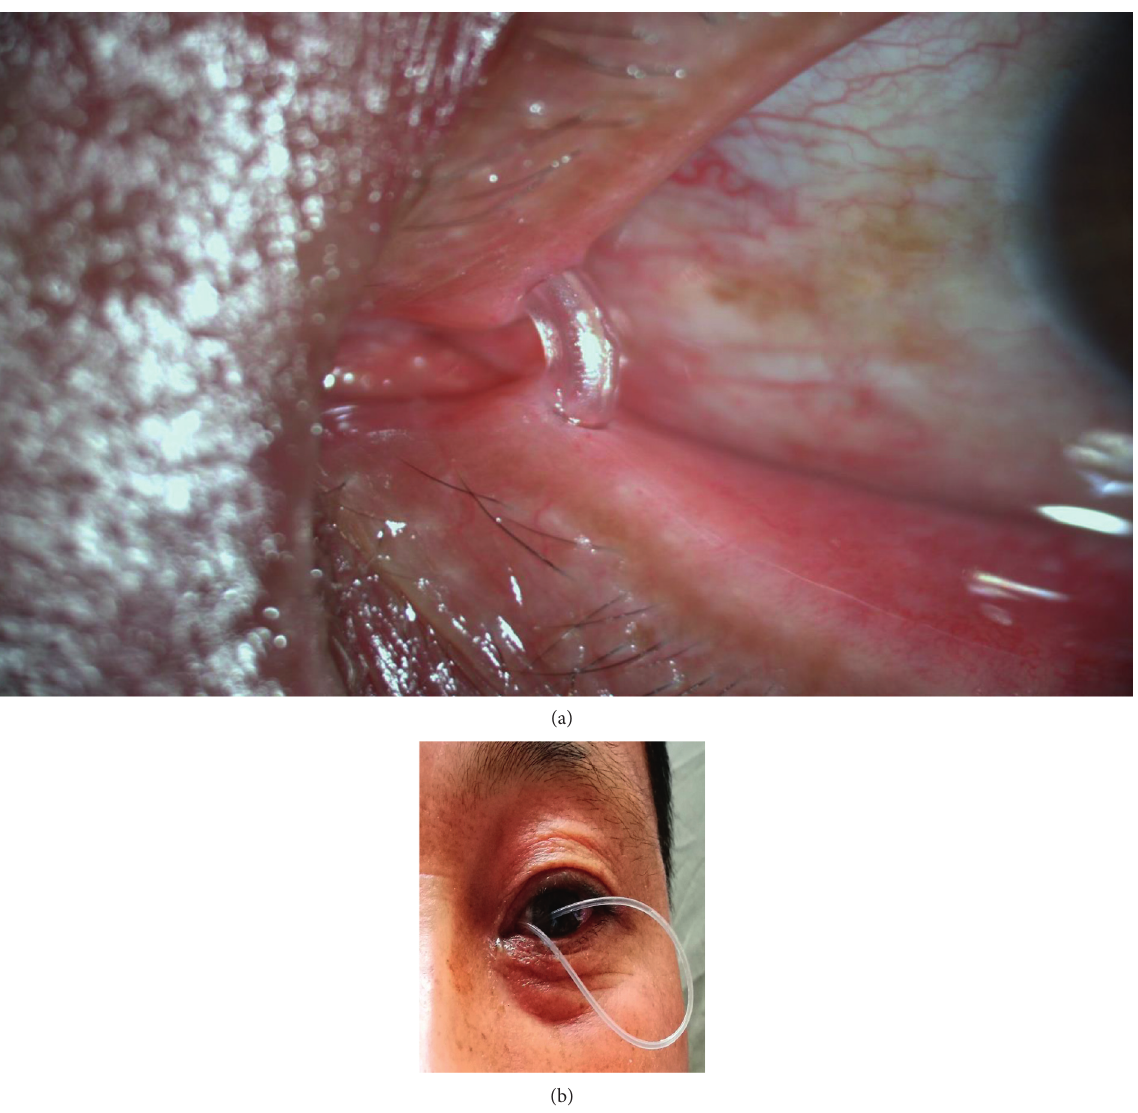
Figure 1: (a) After the bicanalicular-nasal silicone tube is placed by standard methods, little segment of the silicone tube is left to be exposed at the medial canthus. (b) Severe lateral prolapse of the silicone tube at the medial canthus. The loop is lying in front of the cornea, resulting in poor cosmesis, corneal and conjunctival irritation, and corneal erosion if